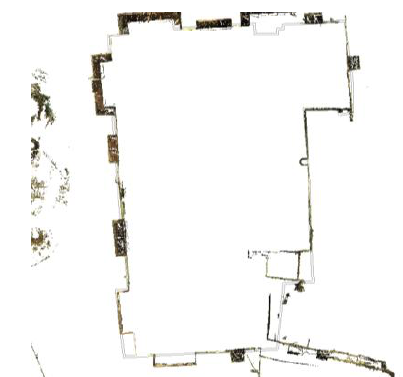
Figure 12. First floor outline plan from